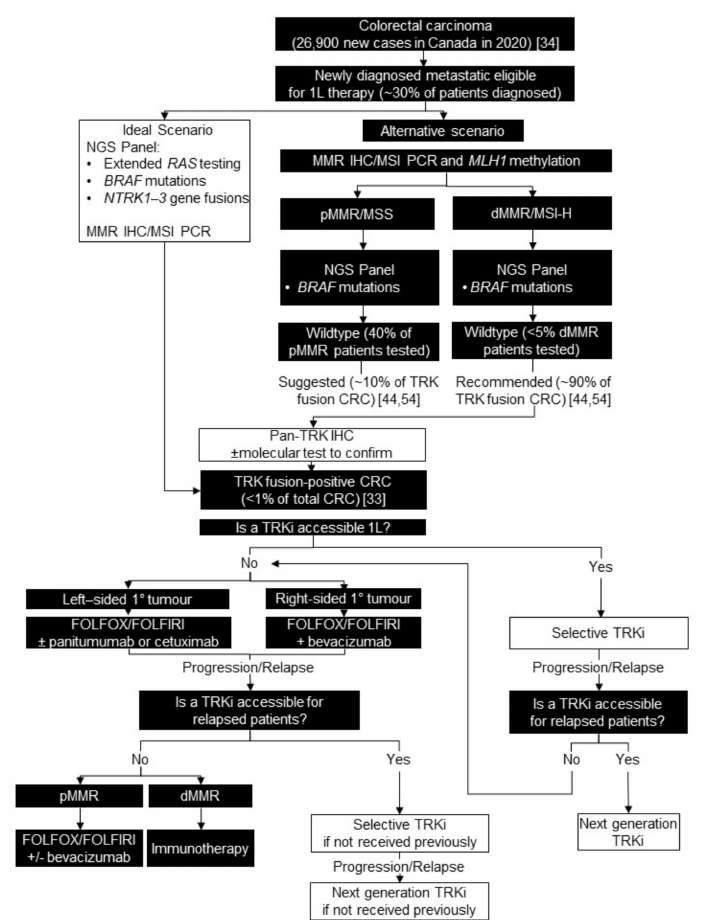
Figure 2. Biomarker testing and treatment for neurotrophic tyrosine receptor kinase ( NTRK) gene fusions in colorectal carcinoma. White boxes with black outlines represent either NTRK gene fusion testing or treatment with a TRKi. Black boxes with white text indicate all other steps that do not include either NTRK gene fusion testing or treatment with a TRKi. BRAF = B-Raf proto-oncogene, serine / threonine kinase; CRC = colorectal carcinoma; d = deficient; FOLFIRI = folinic acid, fluorouracil, and irinotecan; FOLFOX = folinic acid, fluorouracil, and oxaliplatin; IHC = immunohistochemistry; L = line; MLH1 = mutL homolog 1; MMR = mismatch repair; MSI = microsatellite instability; MSI-H = MSI high; MSS = microsatellite sable; NGS = next generation sequencing; p = proficient; PCR = polymerase chain reaction; RAS = RAS type GTPase family; TRK = tyrosine receptor kinase; TRKi = TRK inhibitor. Brenner et al. 2020 [34]; Chou et al. 2019 [44]; Cocco et al. 2019